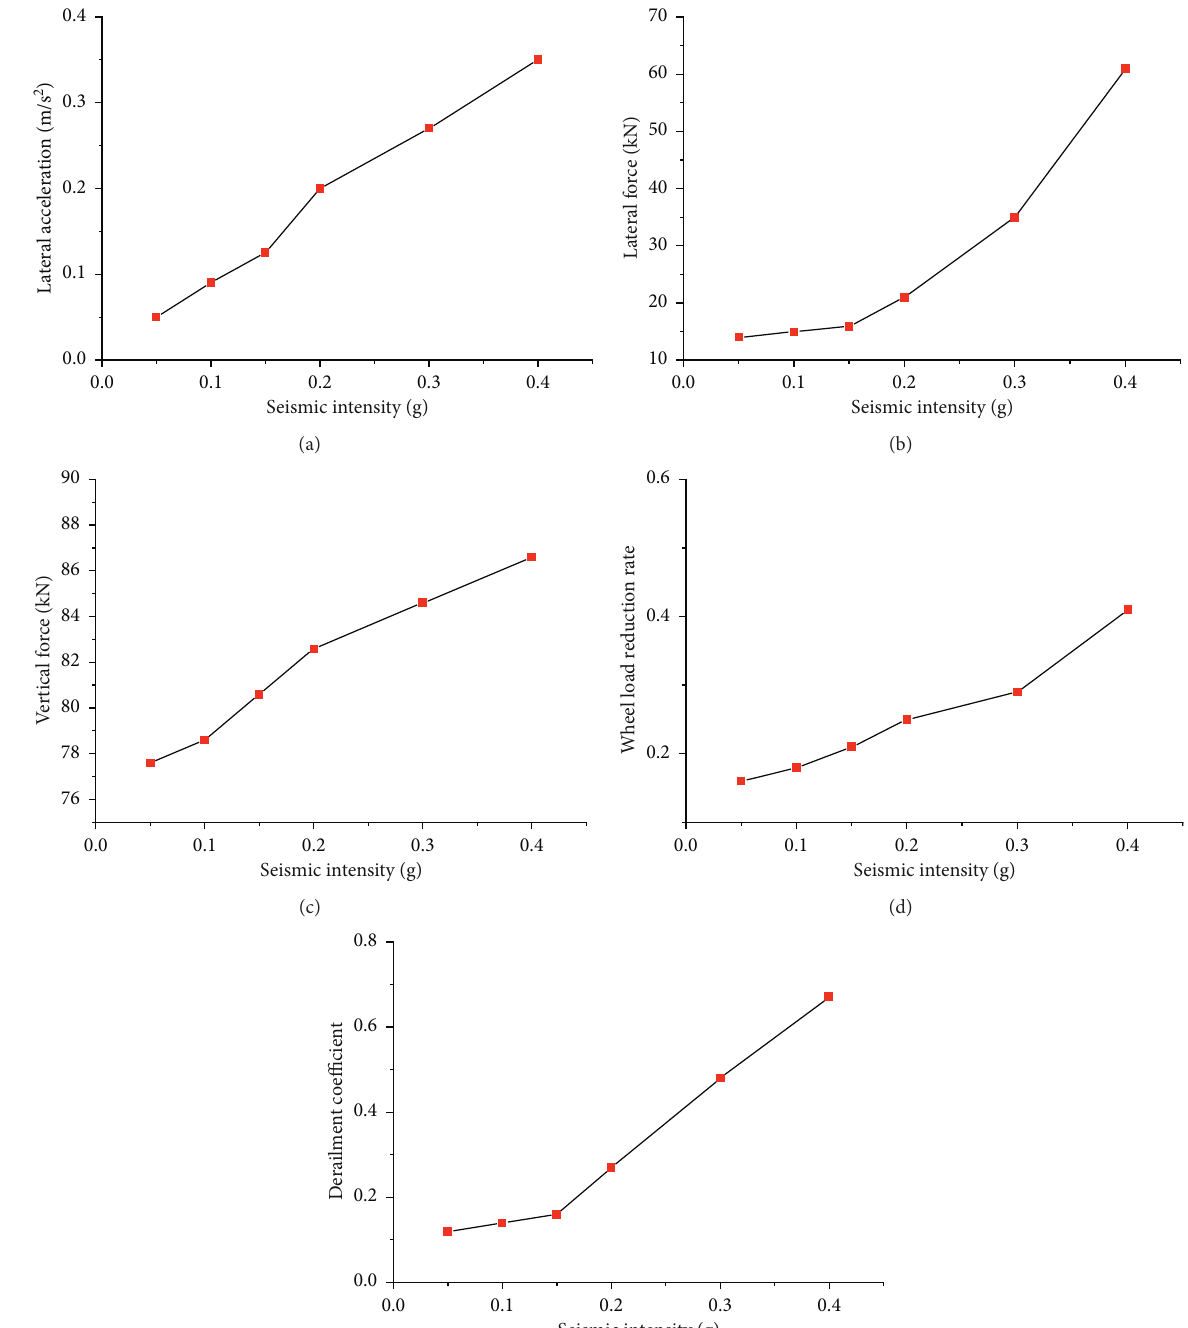
Figure 24: Changes in the dynamic response indexes under the Qian’an wave. (a) Changes in lateral acceleration. (b) Changes in lateral force. (c) Changes in vertical force. (d) Changes in wheel load reduction rate. (e) Changes in derailment